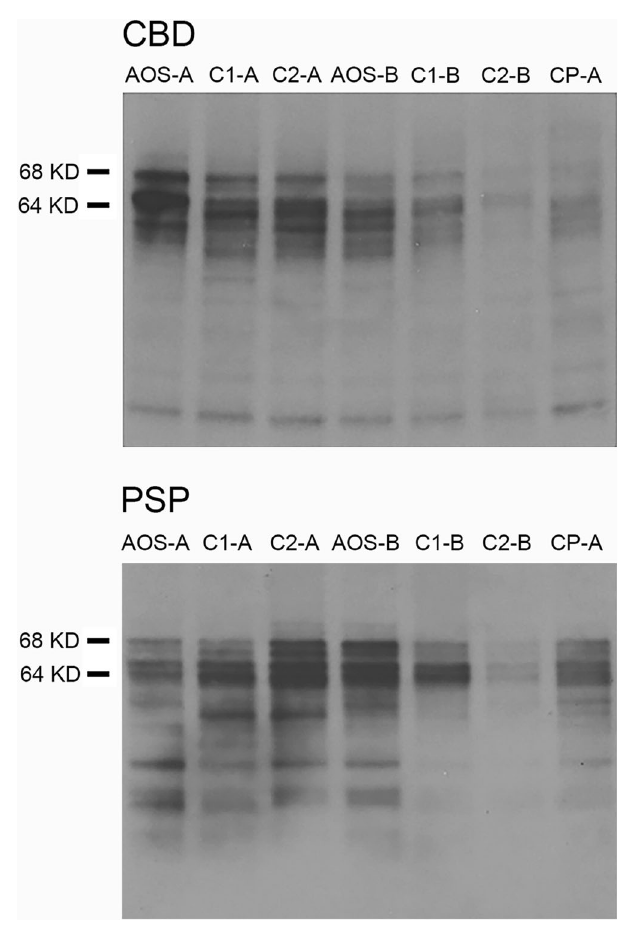
Fig. 8 Tau biochemistry fi ndings in representative progressive apraxia of speech patients with either corticobasal degeneration (CBD) or progressive supranuclear palsy (PSP) pathology, and controls. Western blot fi ndings in representative CBD (top panel) and PSP (bottom panel) cases. Apraxia of speech (AOS) denotes the progressive apraxia of speech cases; C1/2 denotes the matched controls; and CP-A denotes pure controls with no co-pathologies. This experiment was replicated independently in eight CBD cases and seven PSP cases with similar results. Two representative cases for each pathology are shown in this fi gure. The full scan images are provided in Supplementary Fig.